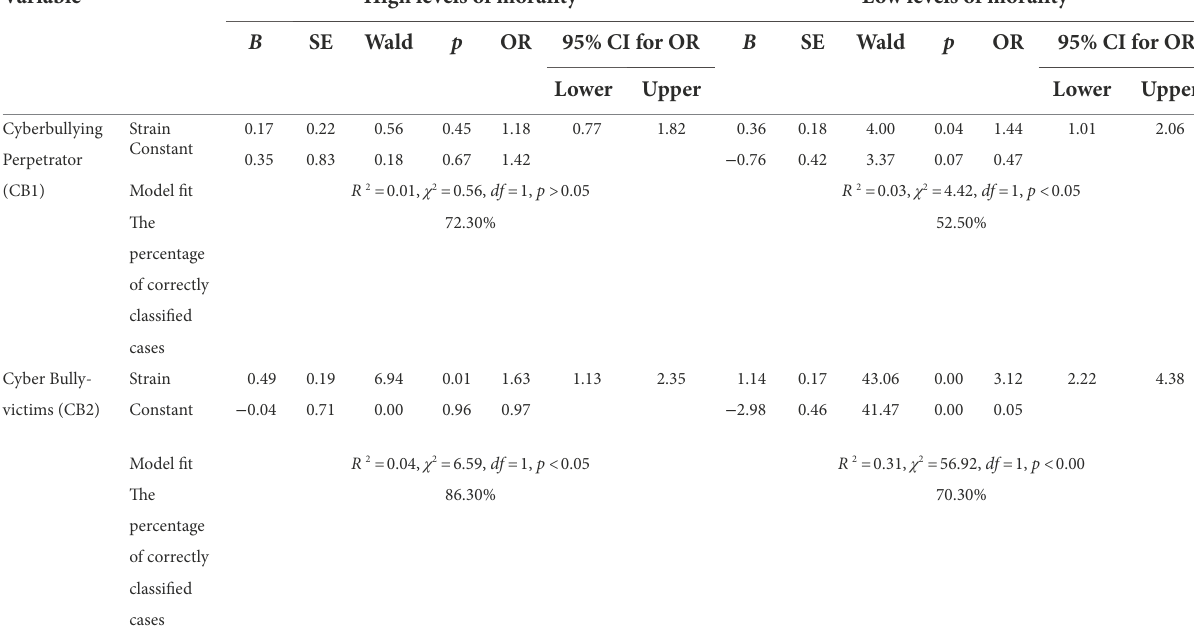
TABLE 6 Results of the binary logistic regression analysis of morality, strain, and cyberbullying. Variable High levels of